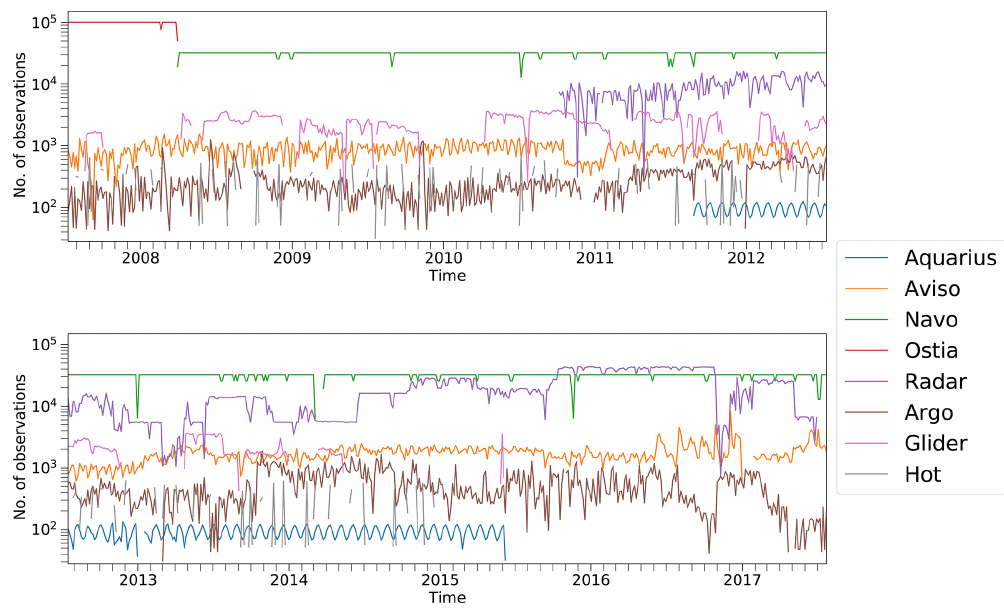
Figure 3. Number of observations used within data assimilation run. Note that there tend to be orders-of-magnitude more satellite or remotely sensed observations than in